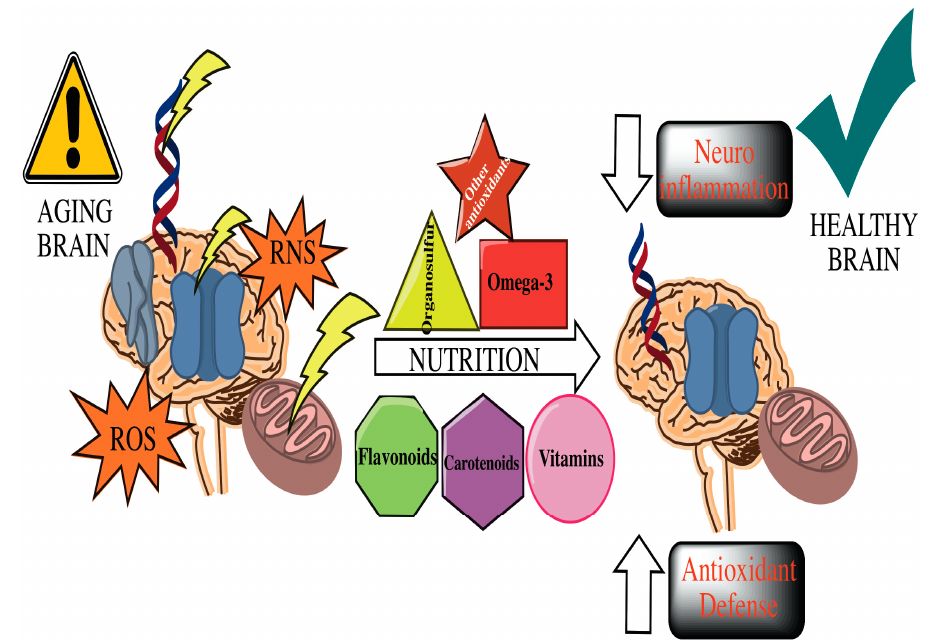
ff ects of nutrition on aging brain and associated Figure 1. Summary of the effects of nutrition on aging brain and associated diseases. Figure 1. Summary of the e